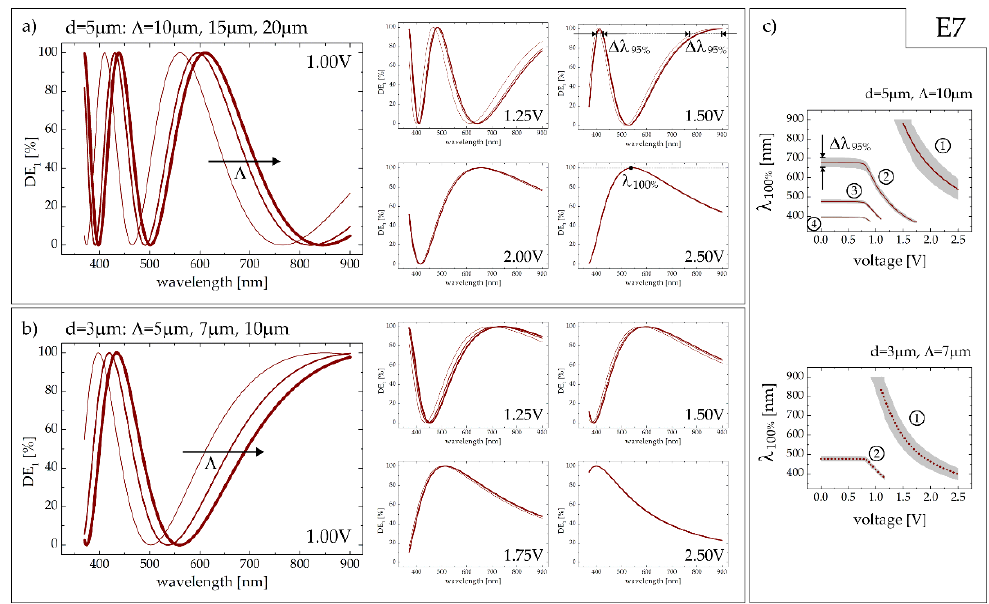
Figure 5. Spectral dependences of the first order diffraction efficiency for E7 LC in the electrically biased cell of a thickness of ( a ) 5 µm and ( b ) 3 µm. the value of applied voltage is given in each graph. Thicker lines in panels ( a , b ) indicate grater periods of the diffraction grating. ( c ) The wavelength at which the maxima of the first order diffraction efficiency are observed (solid lines for d = 5 µm and dotted lines for d = 3 µm) with the gray shadows indicating the spectral ranges (Δλ 95% ) in which DE 1 ≥ 95%.